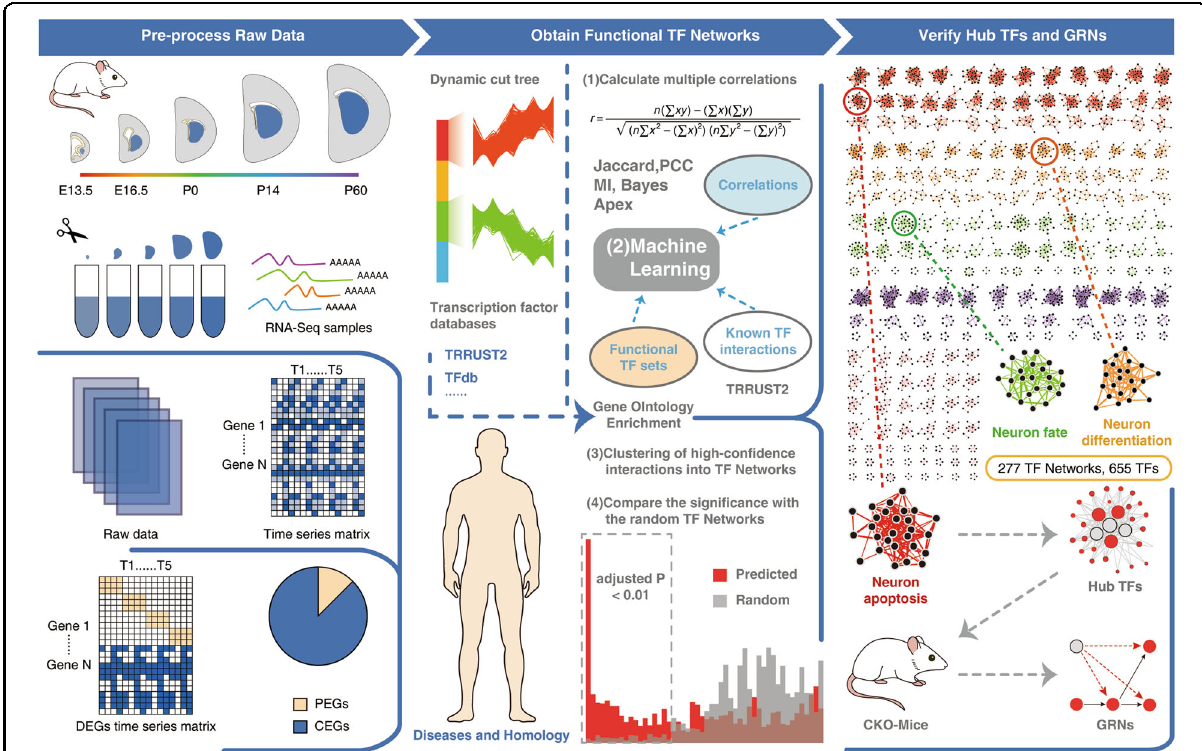
Fig. 1 Overview of the experimental design. Firstly, fi ve time points of mRNA in the striatum or LGE of developing mice were measured using RNA-Seq. Then, the raw transcriptome data were pre-processed to obtain the DEGs, which were divided into two parts (see ‘ Methods ’ ): PEGs and CEGs. Secondarily, the functional TF networks of CEGs were predicted based on co-expression analysis and machine learning. We annotate the homologous and disease genes from existing databases and test the functional signi fi cance of these TF networks. Finally, the hub TFs in the related TF networks were predicted based on the ARACNE algorithm and CKO mice were constructed to further verify the hub TFs and infer their